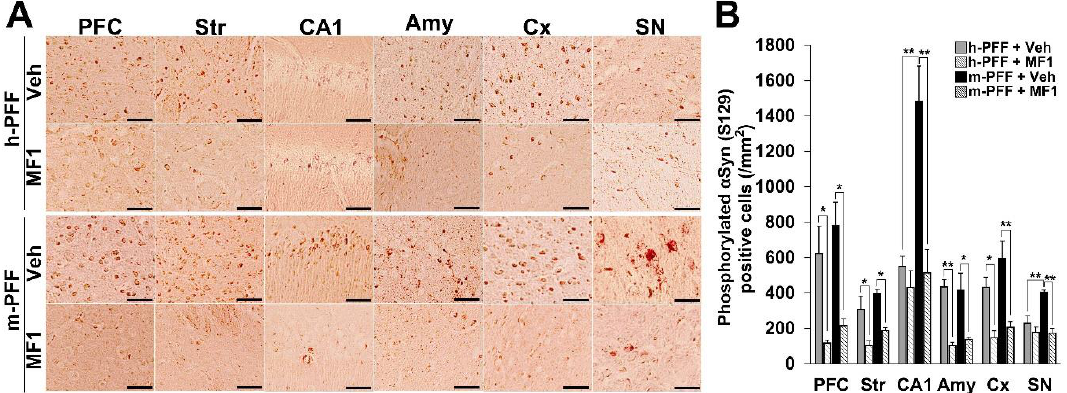
Figure 5. The FABP3 inhibitor MF1 prevents the spreading of phosphorylated α -Syn in human and mouse α -Syn PFF-injected mice. ( A ) Representative images of phosphorylated α -Syn immunoreactivity in the PFC, striatum (Str), hippocampal CA1 (CA1), amygdala (Amy), cortex (Cx), and SNpc in